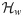
ITQ derived from monthly time series from the JRC-TIP FAPAR dataset.(top) Weighted Permutation Entropy, (bottom) RGB plot of weighted permutation entropy (Hw, red channel), weighted complexity (Cw, green channel), and weighted Fisher Information (Fw, blue channel). An intense color indicates a high value of the respective ITQ.